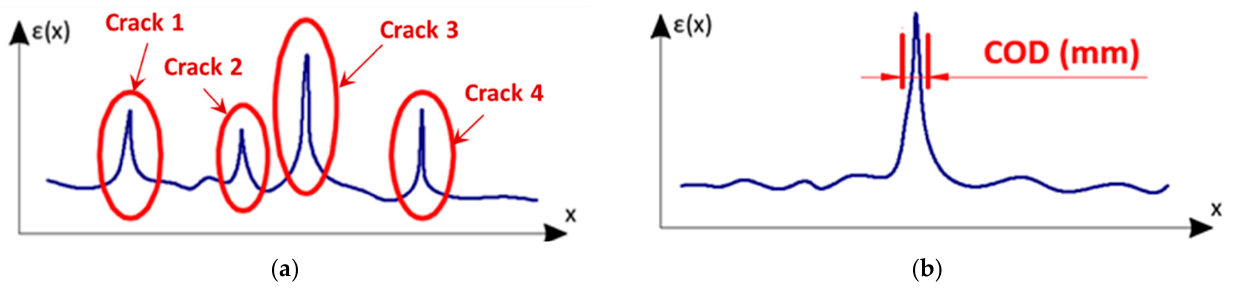
Figure 4. The scheme for crack analysis based on the DFOS system: ( a ) qualitative analysis (detection, location); ( b ) quantitative analysis (width estimation) [6].